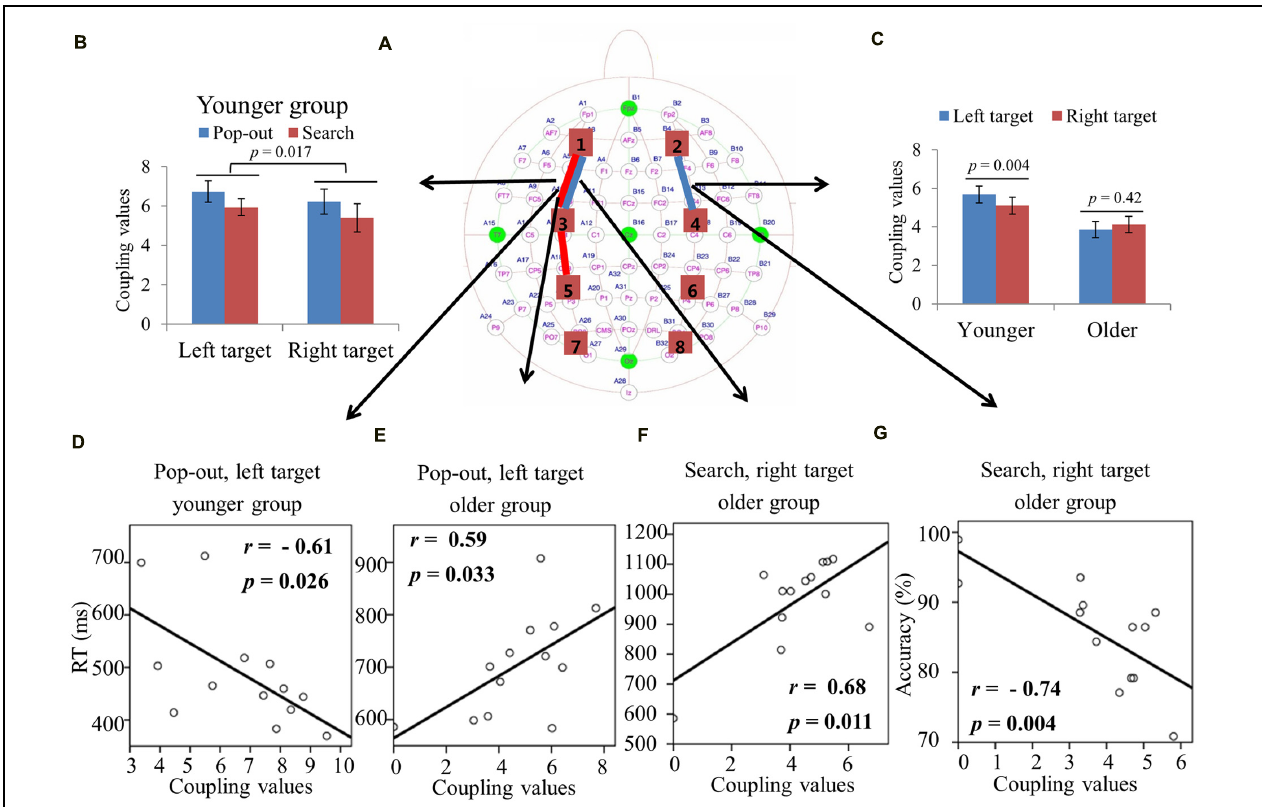
FIGURE 4 | (A) Inter-regions coupling in alpha frequency band. Blue lines indicate main effect of age (younger > older) and red line indicates main effect of condition (pop-out > search). (B) Coupling values between left prefrontal and central-frontal regions as a function of target field and condition in younger subjects, with greater coupling values in the left field target and in the pop-out condition. There was only a main effect of condition for the older group, with greater coupling values in the pop-out condition. (C) Coupling values between right prefrontal and central-frontal regions as a function of target field in younger and older subjects, with greater coupling values in left target than in right target for younger subjects and no difference between right and left targets for old subjects. (D) Linear negative regression between mean RT and coupling value between left prefrontal and central-frontal regions for the pop-out condition with the left field target in the younger group. Linear positive regression between mean RT and coupling value between left prefrontal and central-frontal regions for the pop-out condition with the left field target (E) and for the search condition with the right target (F) in the older group. (G) Linear negative regression between mean accuracy and coupling value between right prefrontal and central-frontal regions for the search condition with the right target in the older group.